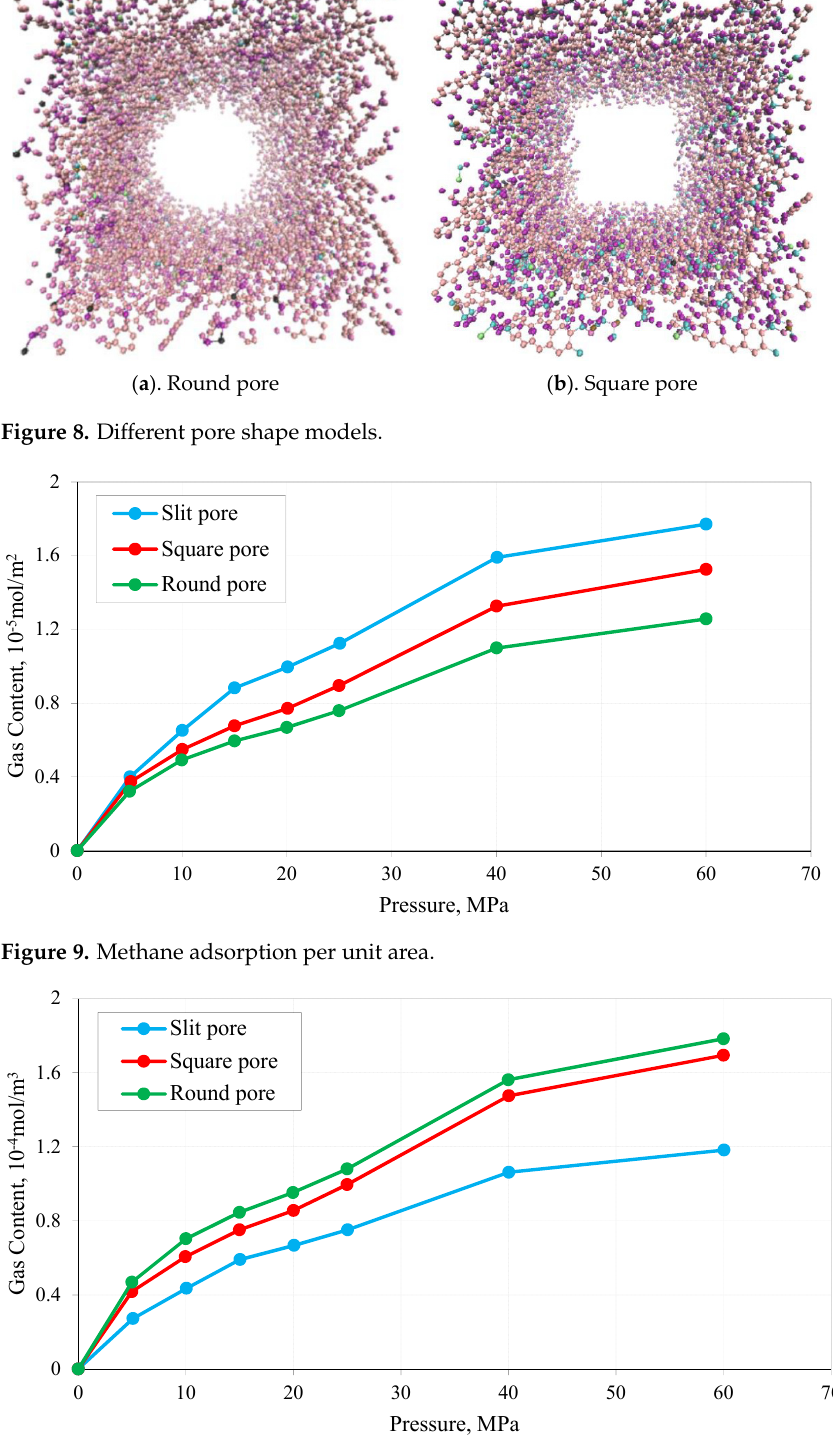
Figure 10. Methane adsorption per unit volume.